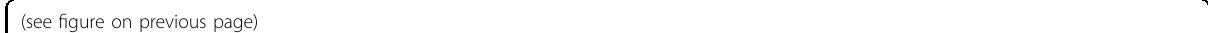
Fig. 5 Gab2 de fi ciency increases the expression of thermogenesis-related genes in HFD-fed mice and differentiated brown adipocytes. A Representative IHC staining images of Ucp1 in BAT from Gab2 KO and WT mice fed with HFD diet for 12 weeks. The scale bar is 50 μ m. B Left panel, representative blots of Ucp1 and Gab2 protein expressions in BAT from Gab2 KO and WT mice fed with HFD diet for 12 weeks detected by immunoblotting analysis. Middle and right panel, the relative grayscale values of Ucp1 (middle) and Gab2 (right) protein blots were normalized with the loading control protein β -Tubulin. C , D The mRNA level of thermogenesis-related genes ( C ) and mitochondrial function associated genes ( D ) in BAT from Gab2 KO and WT mice fed with HFD diet for 12 weeks detected by RT-qPCR. The results were normalized with S18 mRNA levels. E Oil Red O staining of completely differentiated brown adipocytes (Day 6). F Left panel, representative blots of Ucp1 and Gab2 protein expressions during the differentiation of brown preadipocytes detected by immunoblotting analysis. Middle and right panel, the relative grayscale values of Ucp1 (middle) and Gab2 (right) protein blots were normalized with the loading control protein β -Tubulin. G The mRNA level of Gab2 (left panel) and Ucp1 (right panel) during the differentiation of brown preadipocytes detected by RT-qPCR. The results were normalized with S18 mRNA levels. H Ucp1-luciferase reporter activity in response to Gab2 overexpression (left panel) or Gab2 knockdown (right panel) analyzed in immortalized brown preadipocytes by using the Dual-Luciferase Reporter Assay System (Promega). Con, immortalized brown preadipocytes only transfected with Ucp1-luciferase reporter and renilla; si-con, siRNA of control protein. I Representative blots of Ucp1 and Gab2 protein expressions in undifferentiated and differentiated brown adipocytes detected by immunoblotting analysis. β -Tubulin protein was measured as a loading control. Con, undifferentiated brown preadipocytes; Induced, differentiated brown adipocytes. J The mRNA level of common or brown fat-selective genes in differentiated brown adipocytes (Day 6) detected by RT-qPCR. The results were normalized with S18 mRNA levels. The data are presented as mean ± SD from at least six mice in each group or three independent experiments. Statistical difference is indicated: * P < 0.05; ** P < 0.01; *** P <